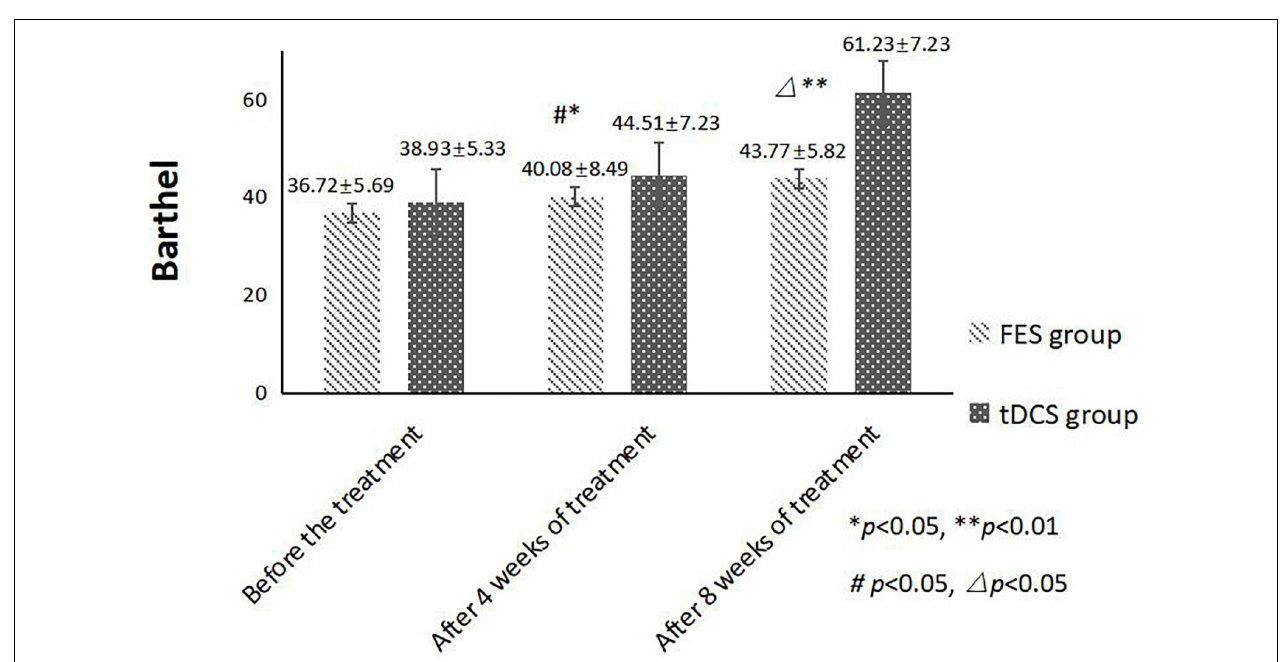
FIGURE 2 | MBI scores comparing improvement before treatment, and after 4 and 8 weeks of FES and tDCS treatments in post-convalescent stroke patients. ∗ Indicates that the mean value of the tDCS and FES groups is significantly different at the same time point, p < 0.05. ∗∗ Indicates that the mean value of the tDCS and FES groups is significantly different at the same time point, p < 0.01. # Indicates that the mean score after treatment is significantly different from that before treatment, p < 0.05. (cid:77) Indicates that the mean value difference at this time point is significant compared with that after 4 weeks of treatment, p < 0.05.